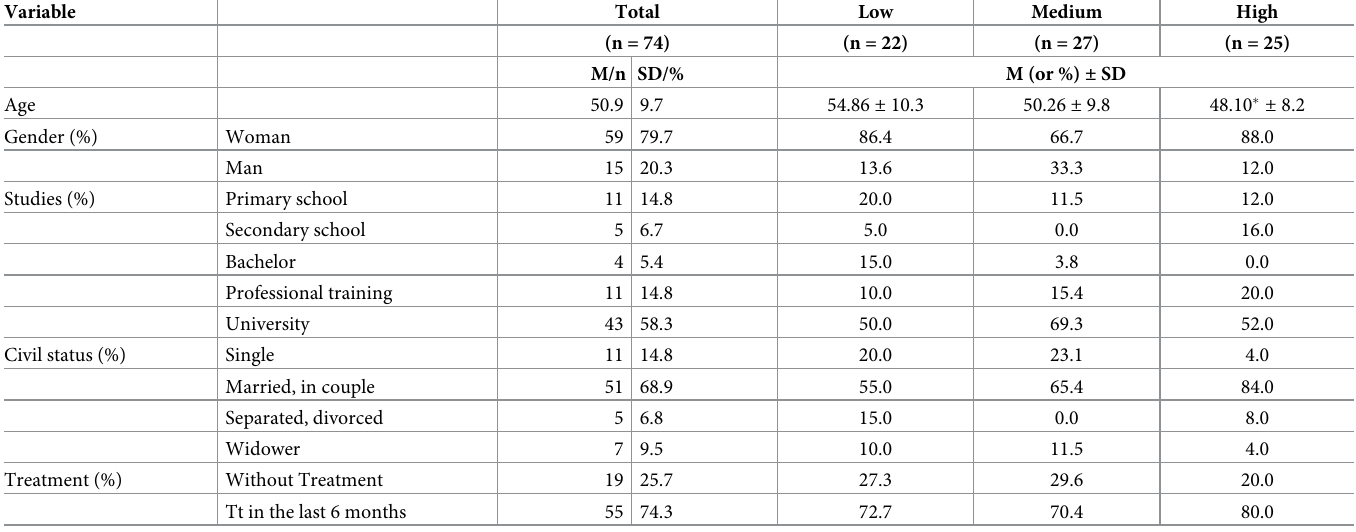
n = sample size, M = mean, SD = standard deviation. � p <